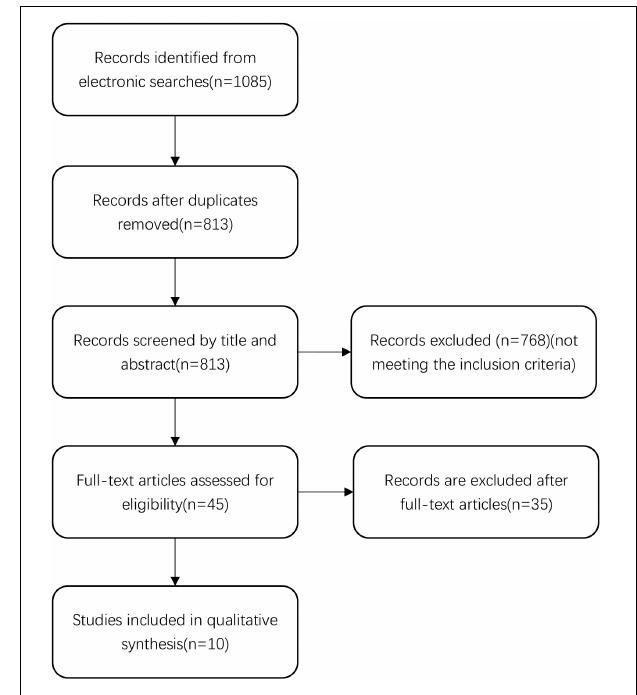
FIGURE 1 | Flow diagram of the study selection